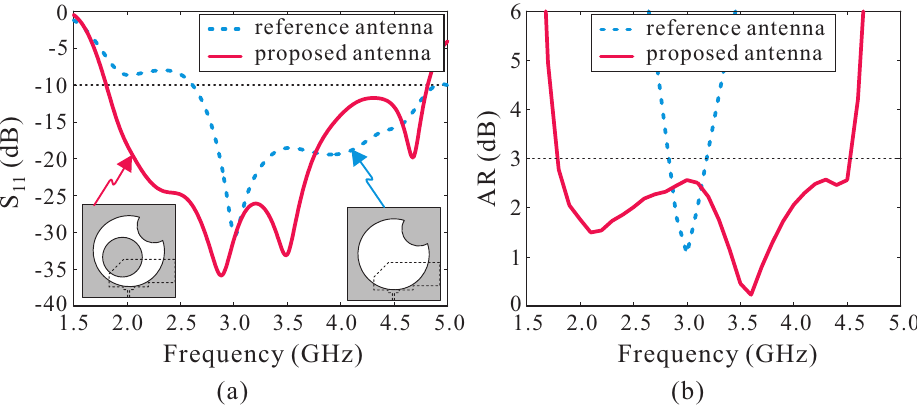
Figure 2. Performance of the antennas with and without circular patch loading: ( a ) reflection coefficients; ( b ) Axial Ratios